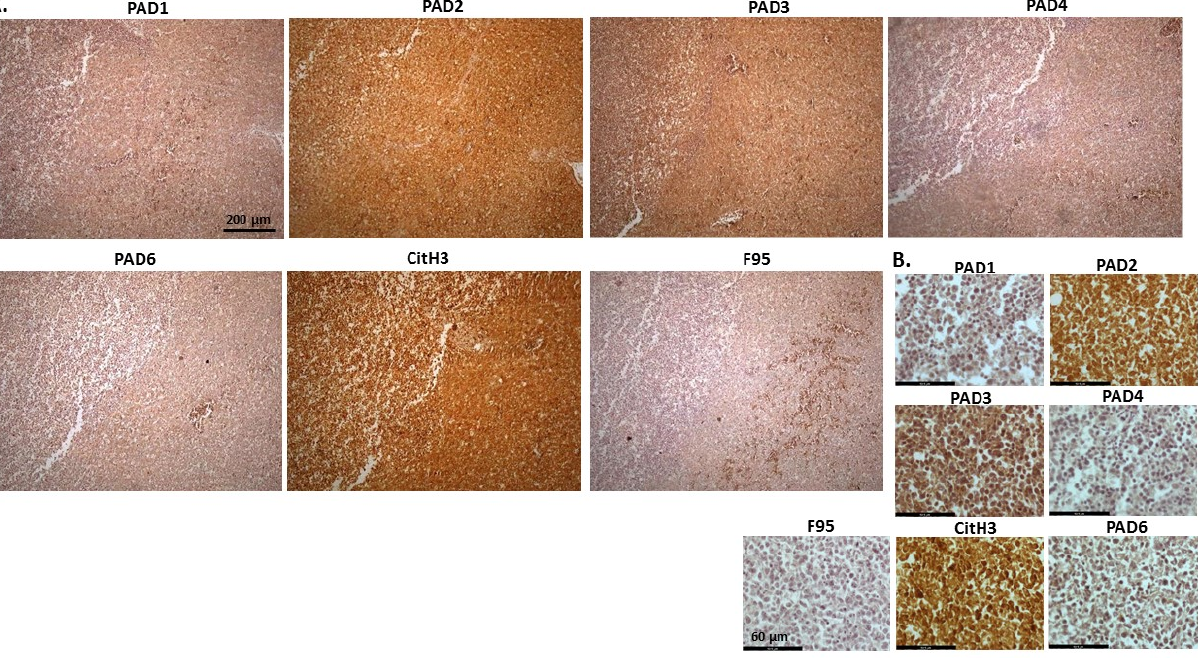
Figure 17. Domestic duck, malignant round cell tumour, liver; probably lymphoma. ( A ) Overview images for PAD1, 2, 3, 4, 6, CitH3, and F95 stainings of serial tissue sections; scale bar represents 200 μ m for all images; 10× objective. ( B ) Higher magnification shown for each staining from the images in ( A ); scale bar represents 60 μ m for all images; 40× objective.